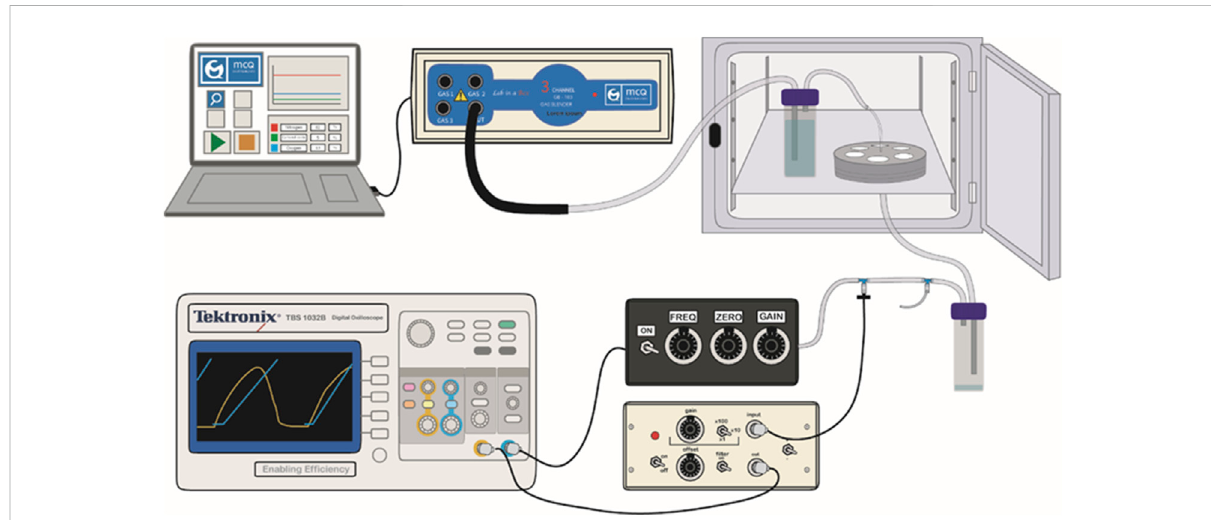
FIGURE 2 Experimentalsetup.Thedrawingshowshowtheairpathfromthegasblender,controlledbythesoftware,tothevalve,throughthechipandthe two water traps to initially humidify and fi nally de-humidify the gas. Cyclic stretch-generating pressure is measured along the experiment with the pressure